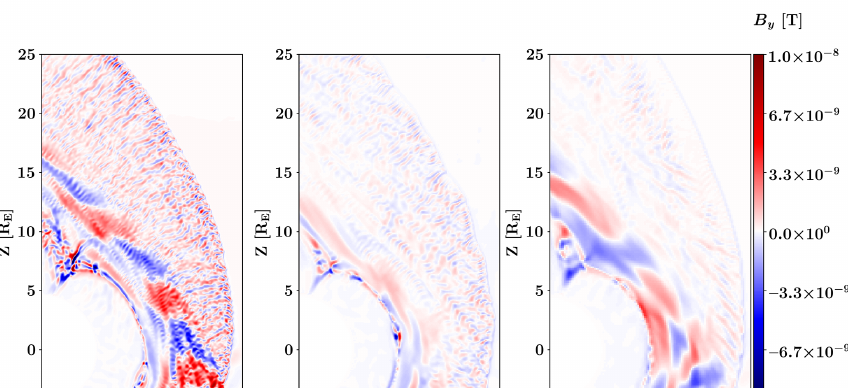
the local plasma frame. Panels (b), (f) and (j) display the slice in the ( v B , v B × V ) plane. Panels (c), (g) and (k) display the ( v B × V , v B × (B × V) ) plane. Panels (d), (h) and (l) display the ( v B , v B × (B × V) ) plane. In panels (b), (c) and (d),